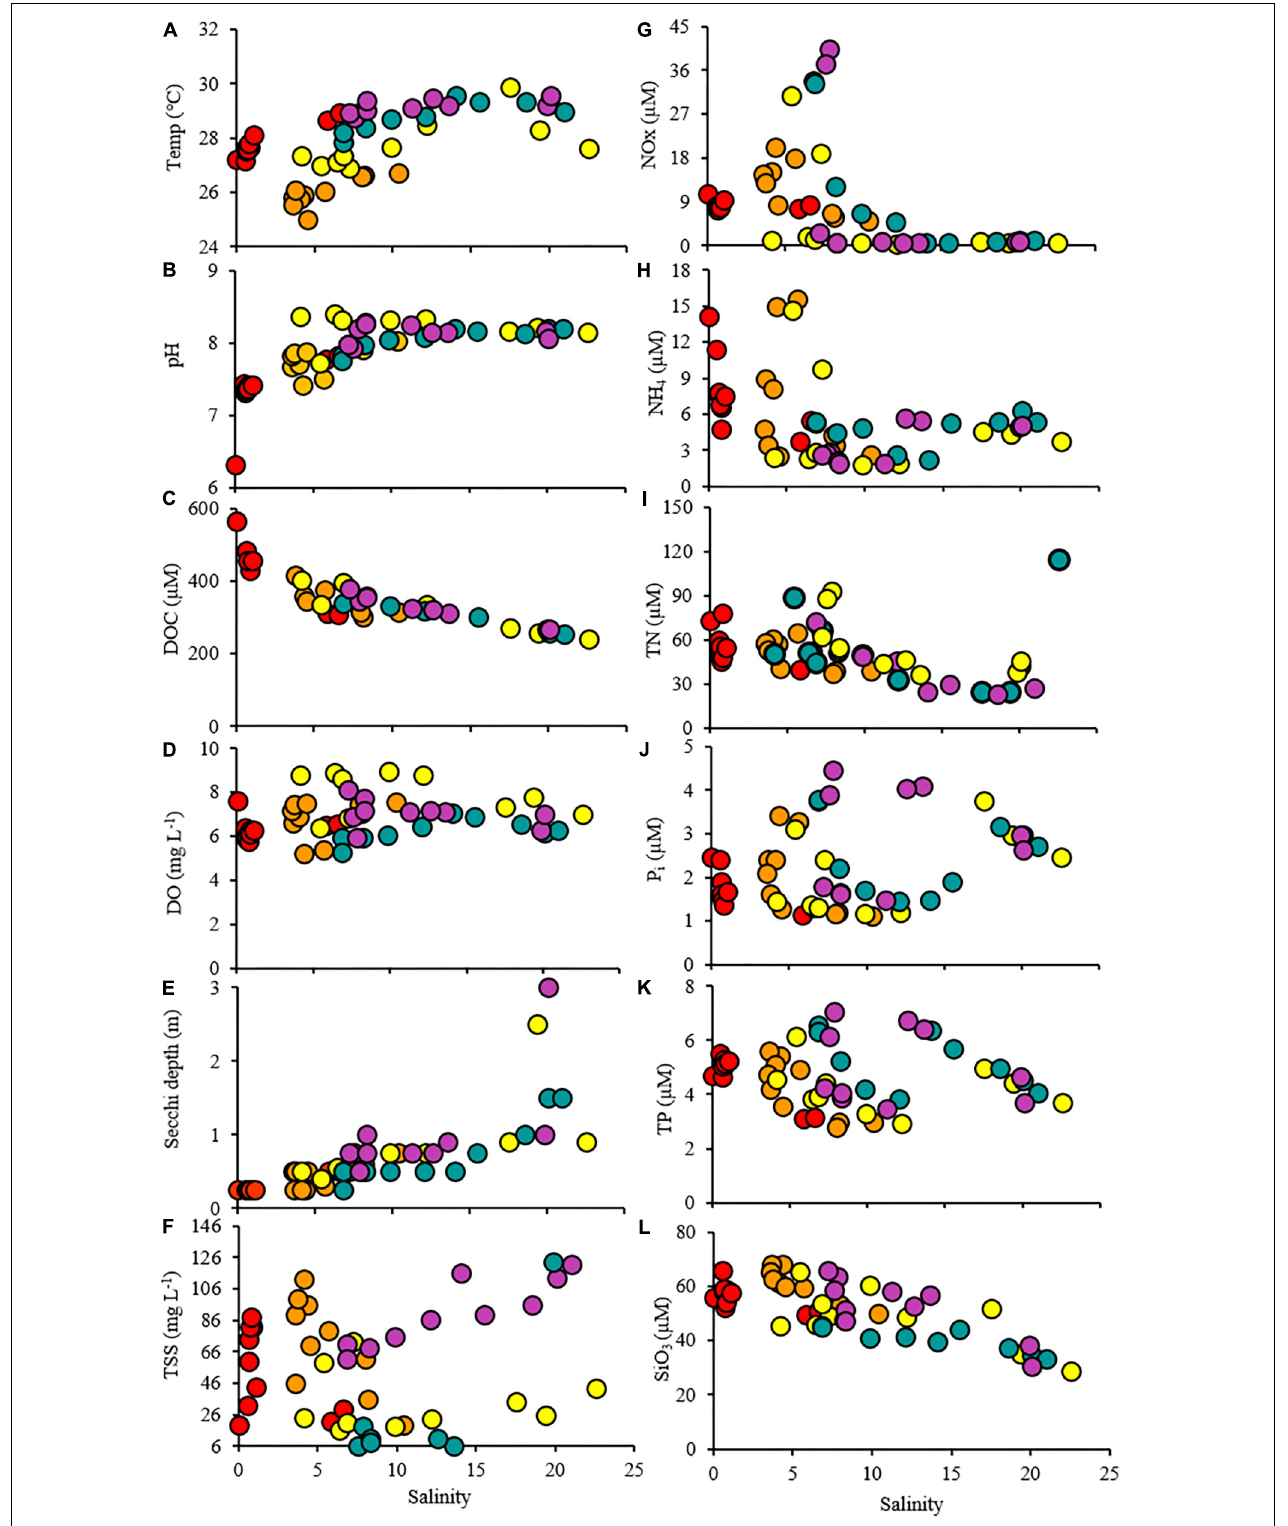
FIGURE 3 | Scatterplots showing the relationship between the salinity and the water quality parameters throughout the study period. Time points are indicated by colors (T1: red, T2: orange, T3: yellow, T4: green, T5: purple).